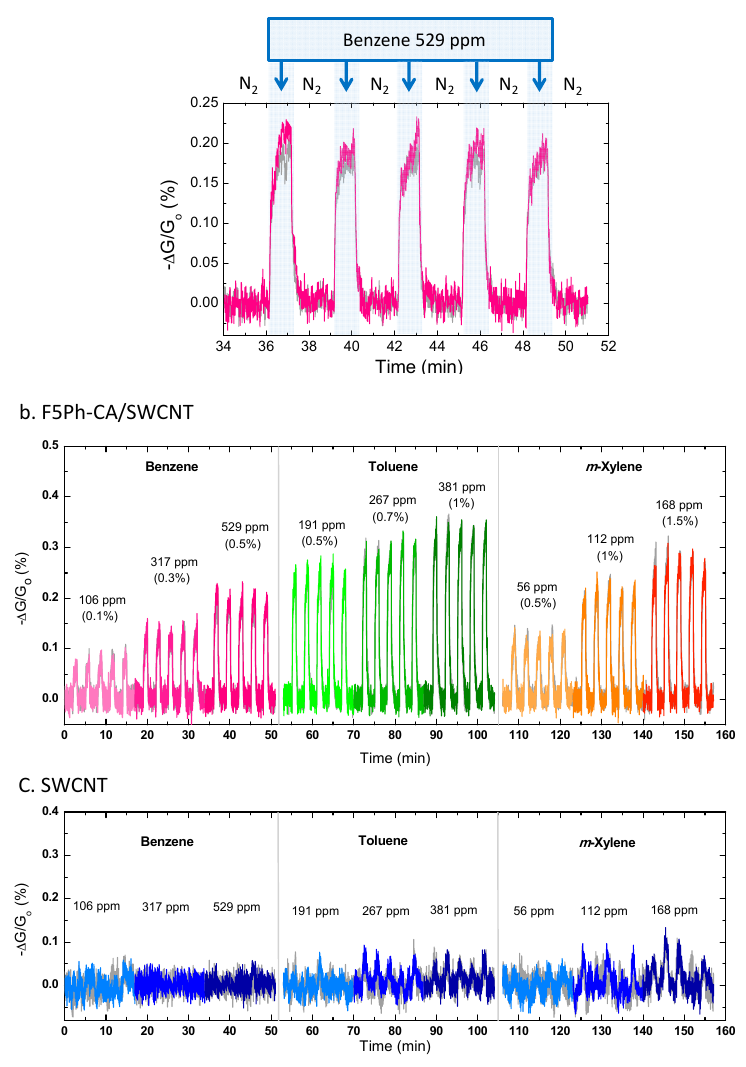
Figure 5. ( a ) Normalized conductance changes [ −Δ G / G o (%)] of the integrated F5Ph-CA concentrator/SWCNT system (F5Ph-CA/SWCNT) when exposed to benzene of 529 ppm, ( b ) normalized conductance changes of F5Ph-CA/SWCNT when exposed to benzene, toluene, and m -xylene vapors of varying concentrations compared to the pristine SWCNT sensor ( c ). The responses from a set of duplicate sensors were consistent, as shown by the grey curves representing the sensing response of the second sensor.